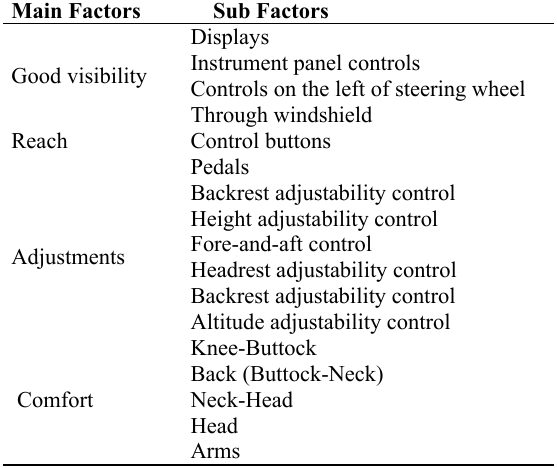
Table 2. Drivers’ expectations from an automobile